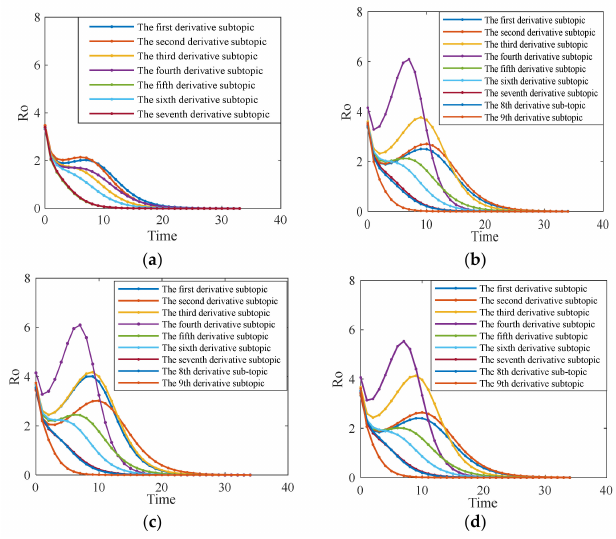
Figure 23. The change of R 0 under different distributions of the amount of